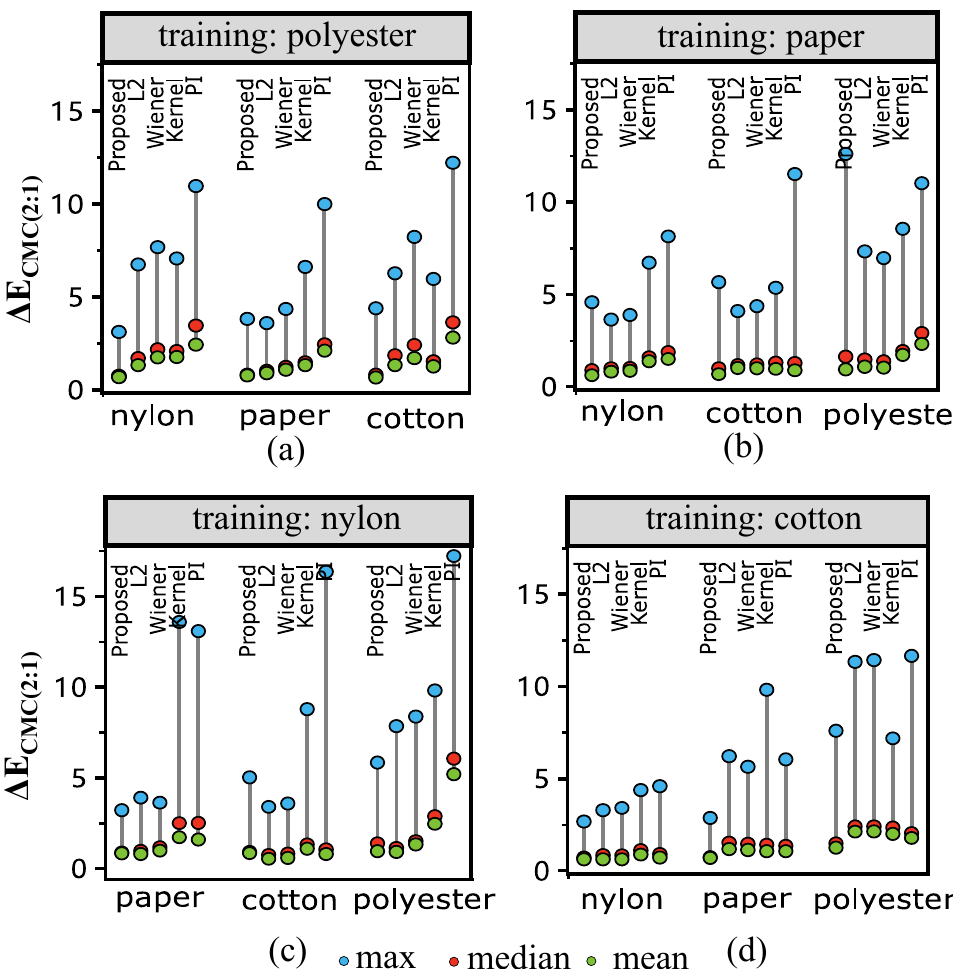
Figure 6. ∆ E results under illumination F2 using different materials as training. “Proposed” refers to our L1-norm penalization method, “L2” refers to the ridge regression (L2-norm penalization), “Wiener” refers to the Wiener method, and “PI” refers to the least-square estimation (pseudo-inverse method). Sub-figures ( a – d ) show the results of using polyester, paper, nylon, and cotton as training samples, respectively. Results show that the proposed method consistently outperforms other methods in the color space; more detailed description is provided in the